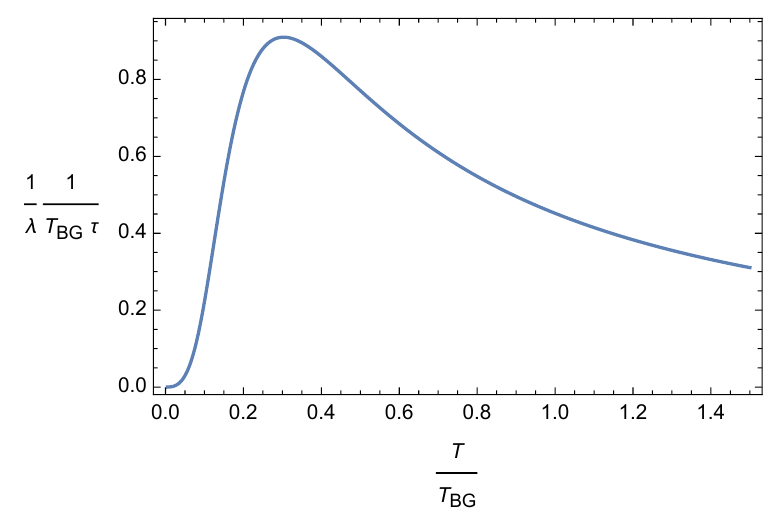
Figure 3: Rate of energy loss to phonons from the Lindhard continuum as a function of temperature in three dimensions from (20). The rate becomes small at low tem- peratures because there are few phonons around. The rate becomes small at high temperatures because high temperature electron-phonon scattering is elastic from the perspective of the electrons and does not efficiently transfer energy out of the electronic subsystem.